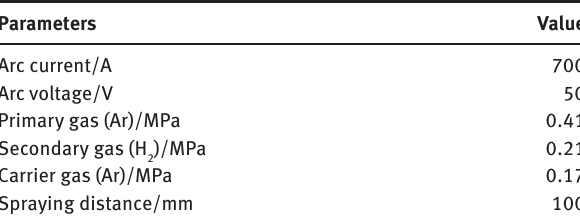
Table 1 Plasma spraying parameters for pure Al and Al powders.